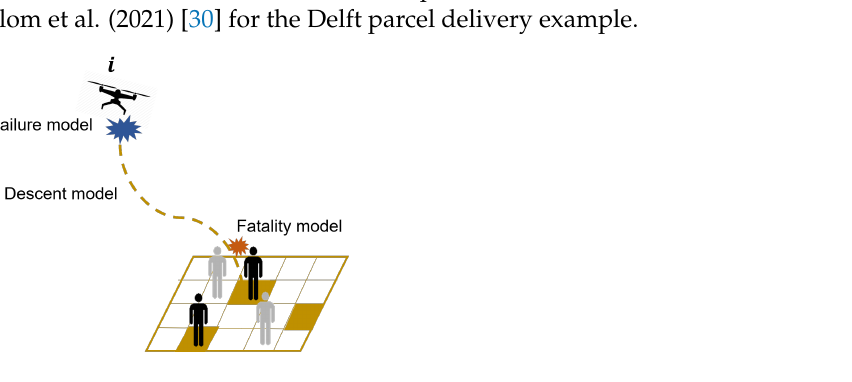
Figure 3. The failure model, descent model, and fatality model in risk